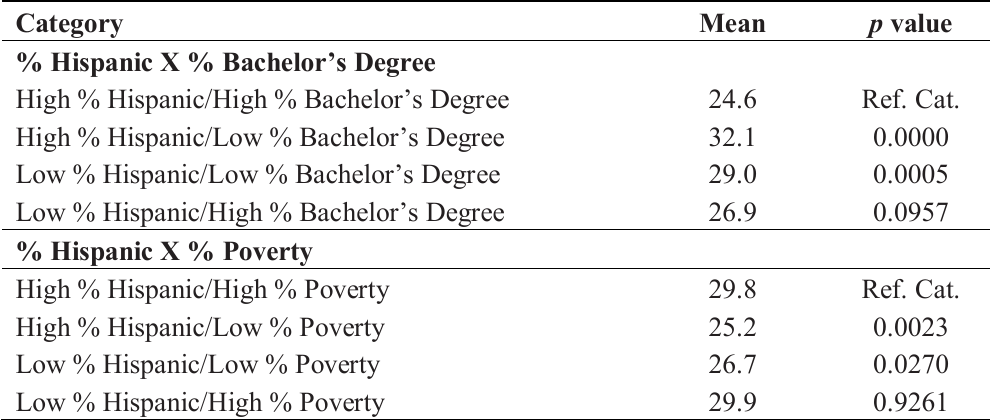
Table 2. Mean Obesity Prevalence by High/Low % Hispanic, % Bachelor’s Degree and % Poverty †